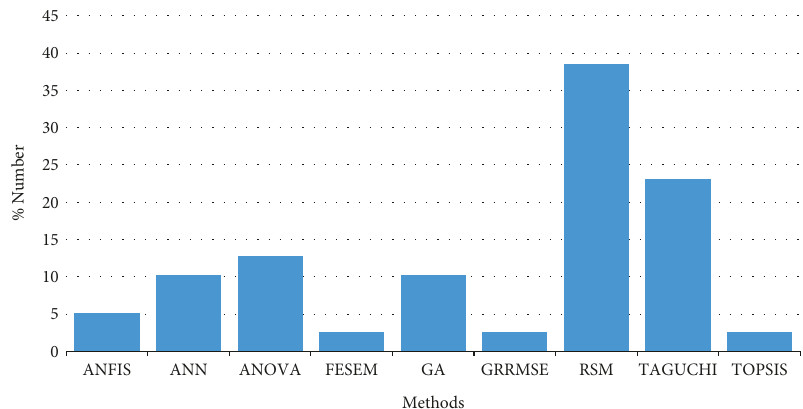
Figure 3: Overview of the methods used in the optimization of FDM process parameters.